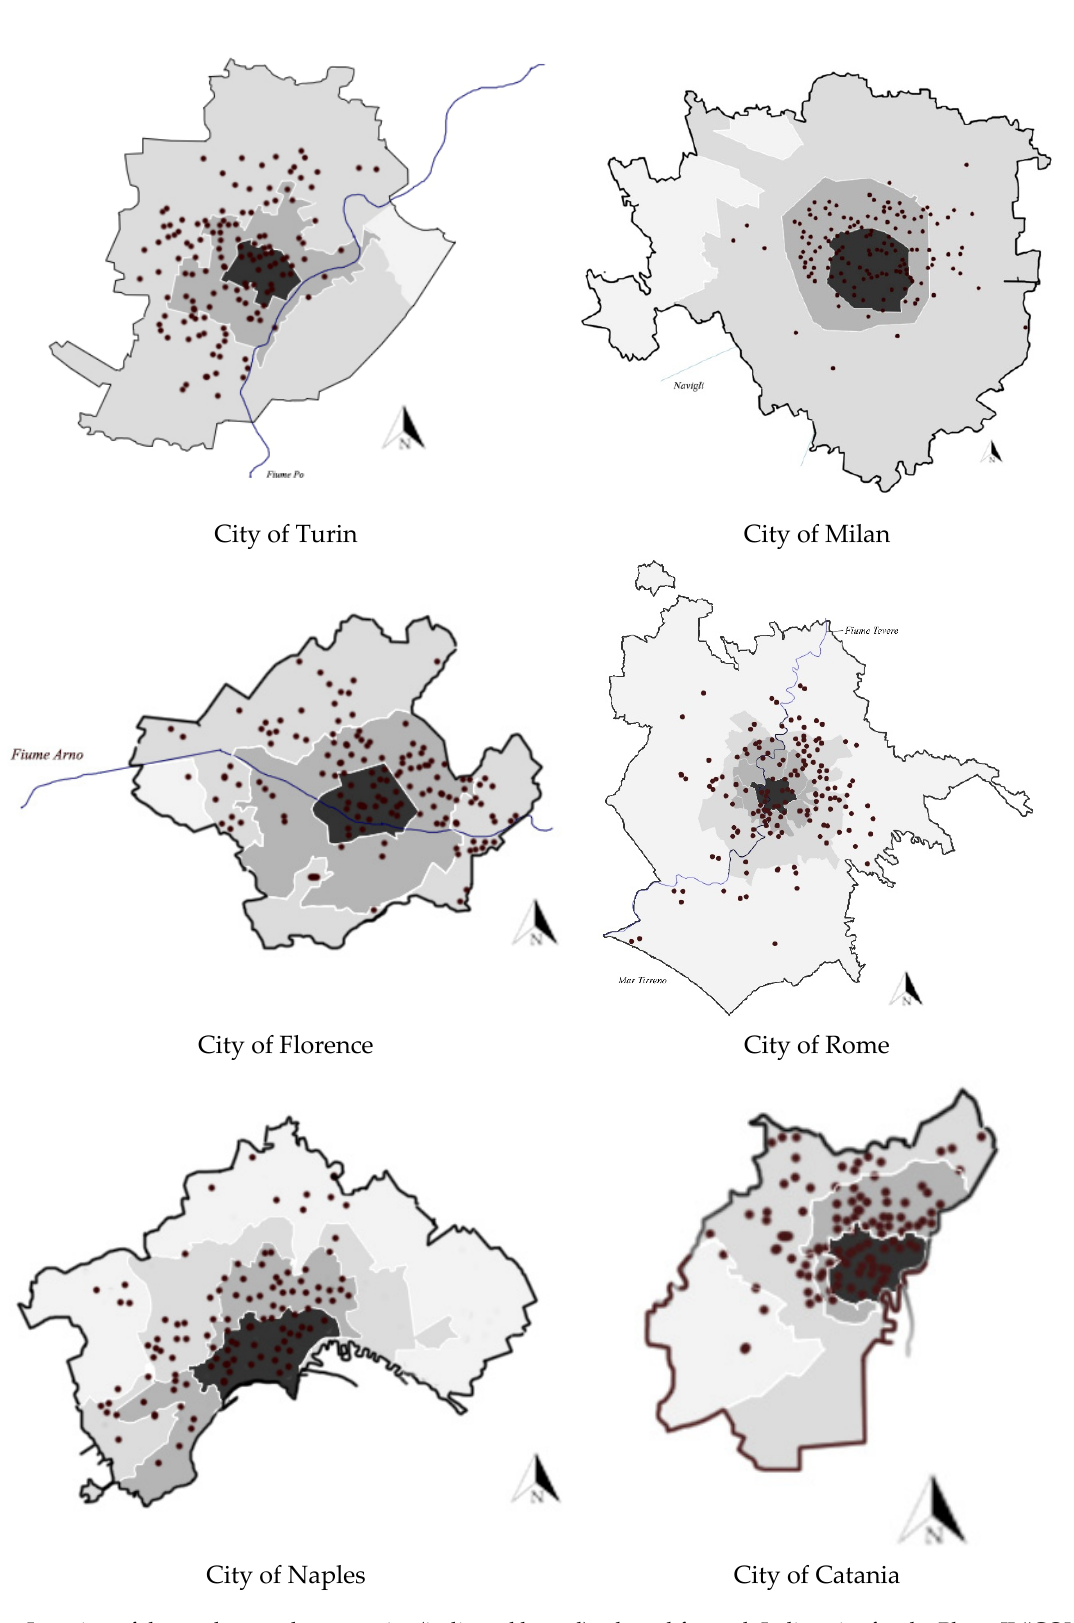
Figure 3. Location of the study sample properties (indicated by red) selected for each Italian city for the Phase II “COVID-19 pandemic in progress”.